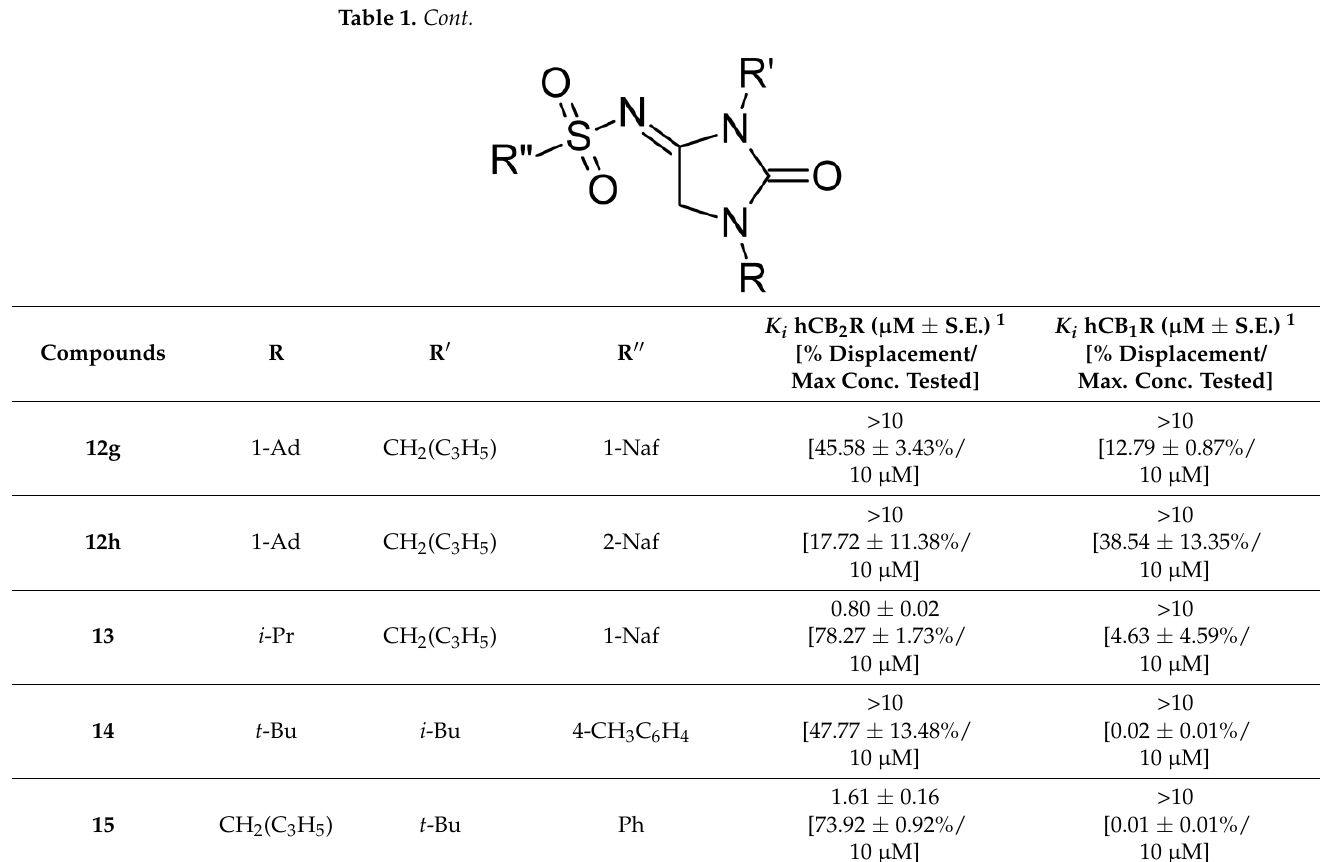
Table 1. Cont. Table 1. Affinity values for hCB1R and hCB2R of compounds of general